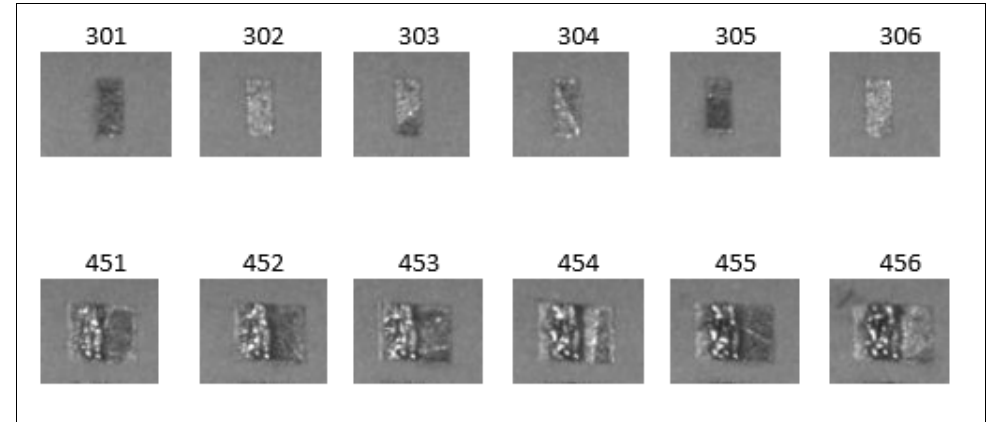
Figure 10. The difference in the shape of the test specimen at different